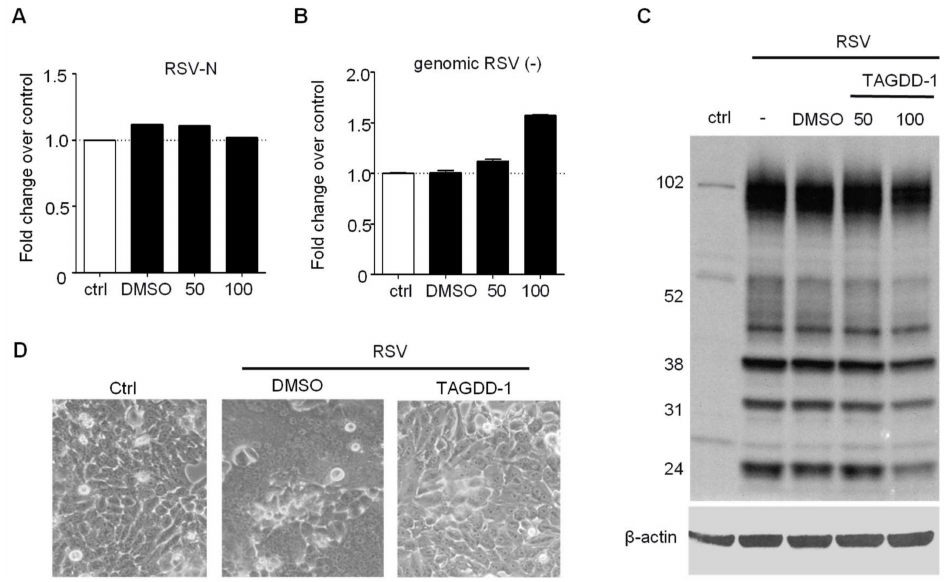
Figure 2. TAGDD-1 does not affect initial steps of RSV replication. A549 cells were infected with RSV MOI 3 and treated with TAGDD-1 at 50 and 100 µ M concentrations at 1 h after infection. The cells were harvested 24 h later to extract total RNA ( A , B ) or cellular protein ( C ). ( A ) Real-time PCR for RSV-N transcripts normalized to control RSV only using 2 − ∆∆ C t method ( B ) Absolute quantification by real-time PCR for genomic RSV (-) RNA transcripts normalized to control RSV only. ( C ). Western blot for RSV proteins. Total of 30 µ g of protein was used per lane. The membrane was probed using rabbit polyclonal anti-whole RSV antibody (Bio-Rad, Hercules, CA, USA). The membrane was re-probed with anti-human β -actin antibody for loading control. ( D ) Light microscopy photograph (20 × ) of HEp-2 cells uninfected and infected with RSV MOI of 0.01 for 48 h in the presence of DMSO or TAGDD-1 at 50 µ M